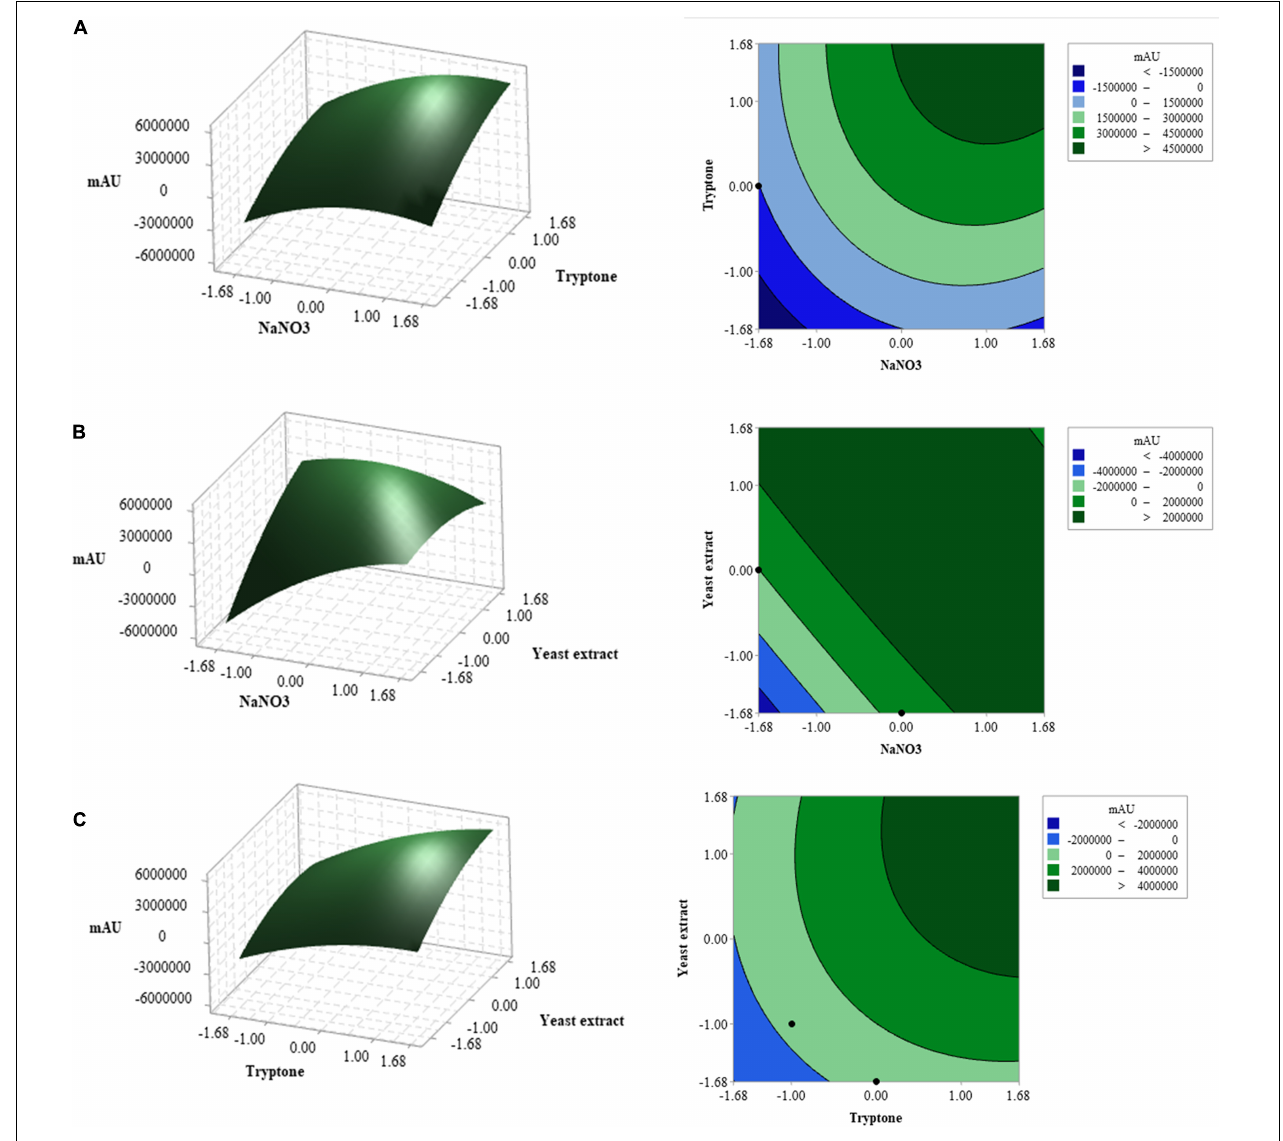
FIGURE 3 | Three-dimensional (3D) response surface plots and two-dimensional (2D) contour plots of three factors affecting cyclopiazonic acid production by Penicillium commune KACC 45973. When the interaction of any two factors was plotted, the other factor was set at the central point: (A) tryptone and NaNO 3 , (B) yeast extract and NaNO 3 , and (C) tryptone and yeast